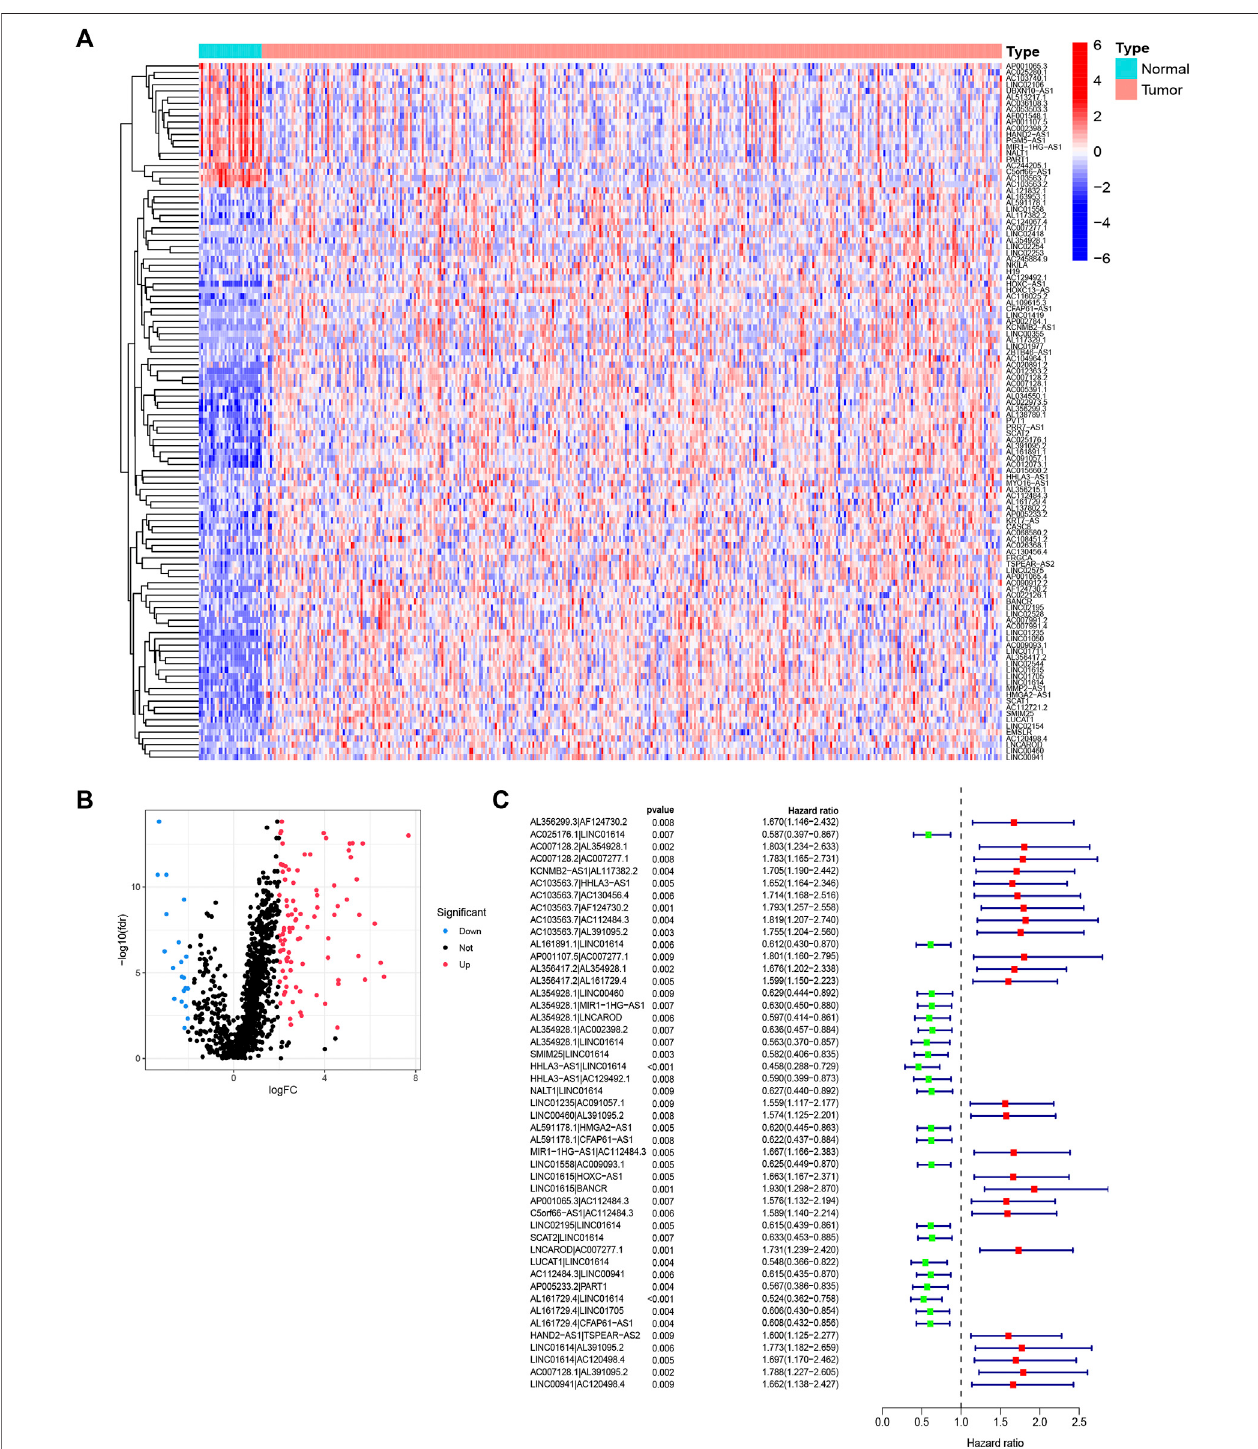
FIGURE 1 | Identi fi cation of differentially expressed ferroptosis-related lncRNAs (DElncRNAs) and differentially expressed ferroptosis-lncRNA pairs (FRLPs). (A) Heat map of 112 DElncRNAs. Red dots and blue dots represent upregulated and downregulated lncRNAs in tumor samples, respectively. (B) Volcano map of 112 DElncRNAs. (C) Forest plot showing 47 prognostic FRLPs identi fi ed by univariate Cox analysis.